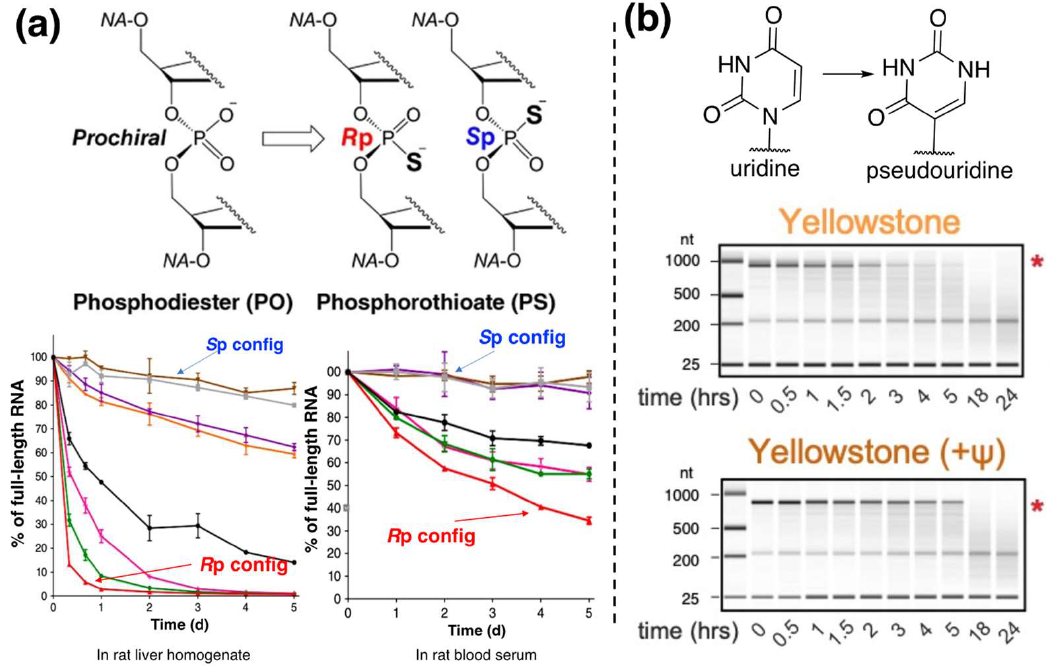
Figure 2. The effect of mRNA chemical modifications of on its stability. ( a ) Phosphorothioate modification and the effect of two configurations of the phosphorous atom on mRNA stability in rat liver homogenate and rat blood serum. Reproduced from Butler et al. with permission [77]; ( b ) evidence of pserudouridine modification on mRNA stability (confirmed by gel electrophoresis), * means more/less degradation. Reproduced from Leppek et al. with permission [36].